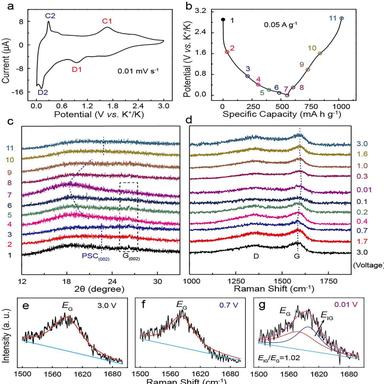
(a) CV curve of G@PSC at 0.01 mV s1 . (b) The charge–discharge curve of G@PSC at 0.05 A g1 and points selected by potential. The ex-situ XRD (c) and Raman (d) spectra corresponding to the above positions. (e) The evolution of G-band when discharged from 3.0 V to 0.7 V, finally to 0.01 V.